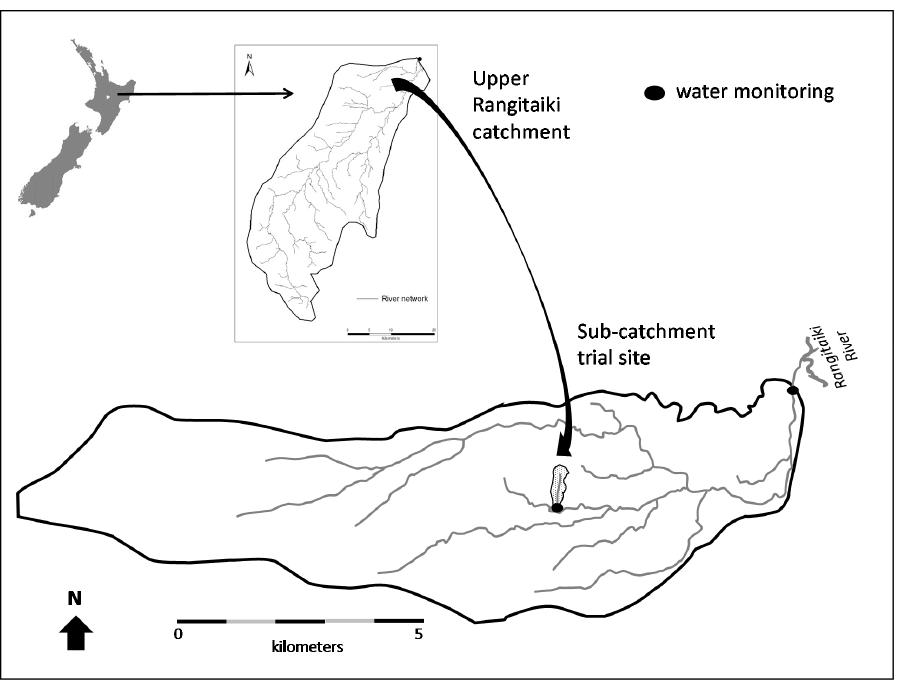
Figure 2. Location of herbicide trial in a sub ‐ catchment of the upper Rangitaiki River catchment, New Zealand. Figure modified from [30].